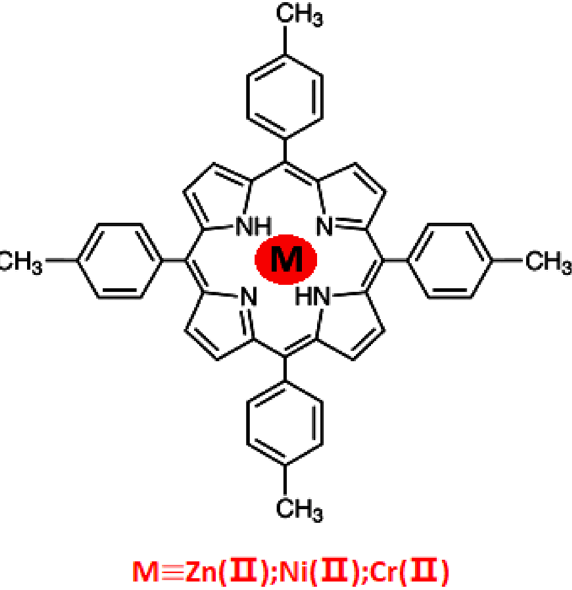
Figure 1. Chemical structure of the complexes of the 5,10,15,20-tetrakis(4-methylphenyl) porphyrin with the three metals (zin, nickel and